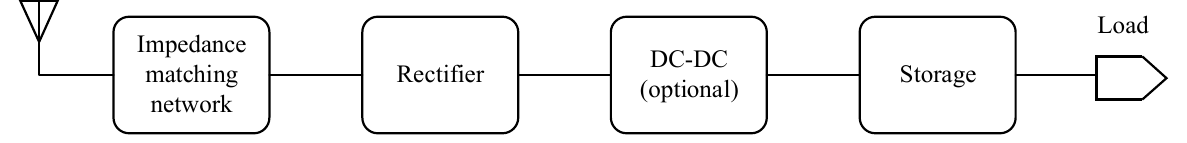
Figure 12. The architecture of the RFEH